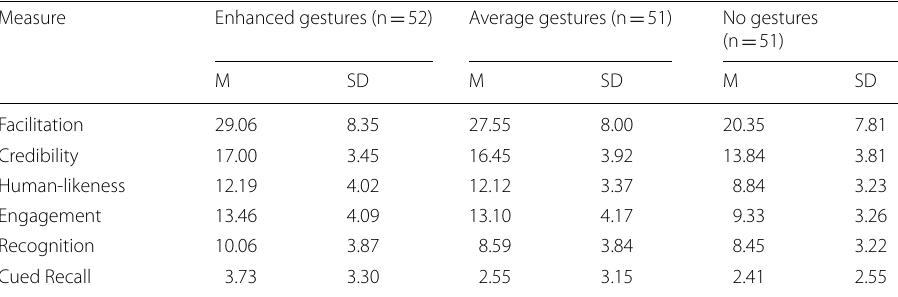
Table 1 Means and standard deviations for agent persona subscales, recognition, and cued recall